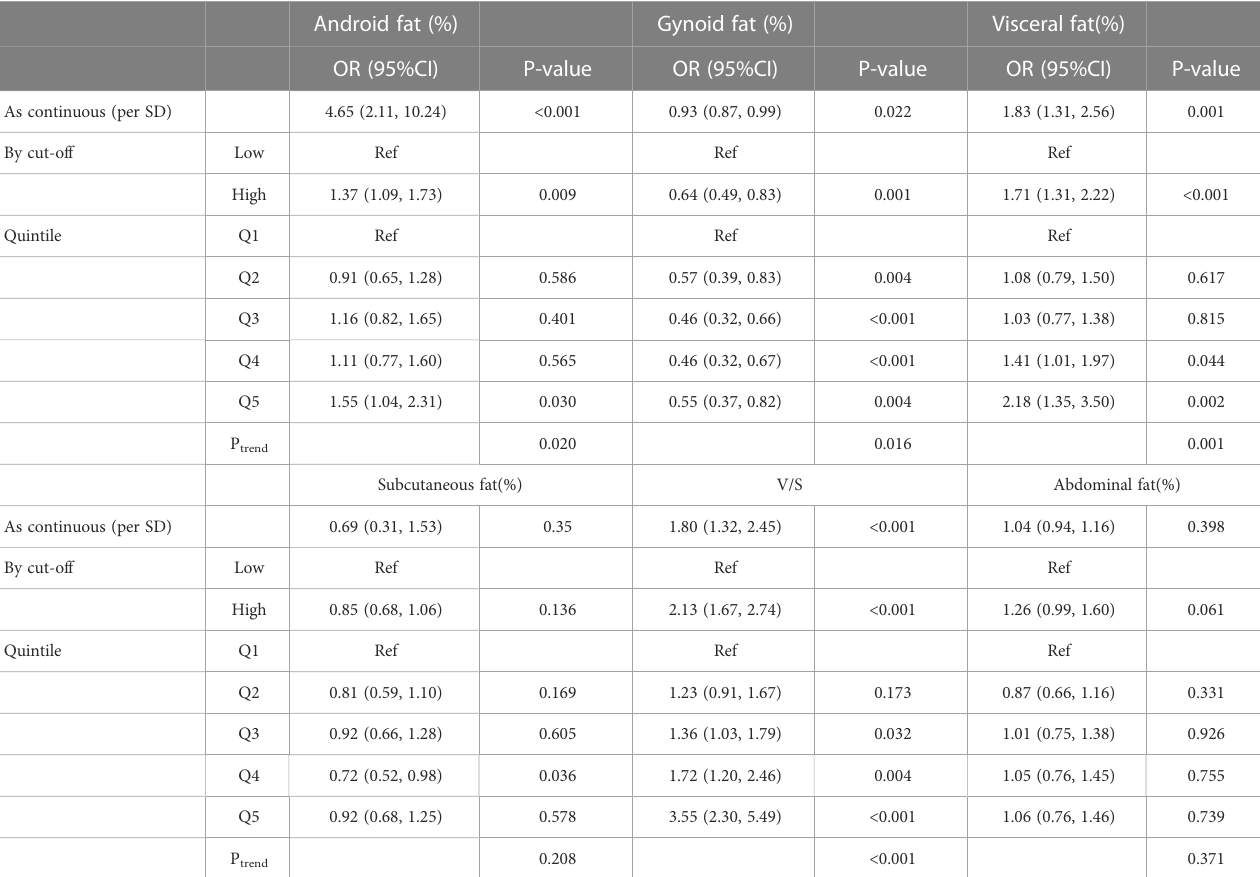
TABLE 3 Odds ratio (95%CI) of comorbidity risk with different fat distribution in female obese